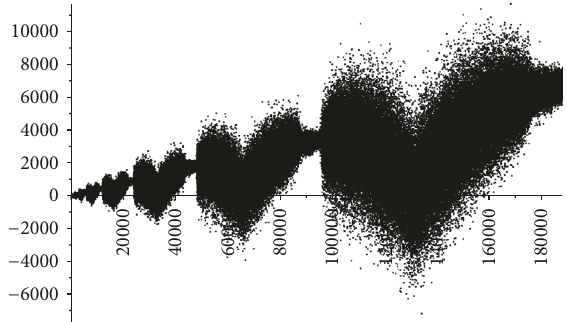
Figure 3: Hofstadter Chaotic Heart